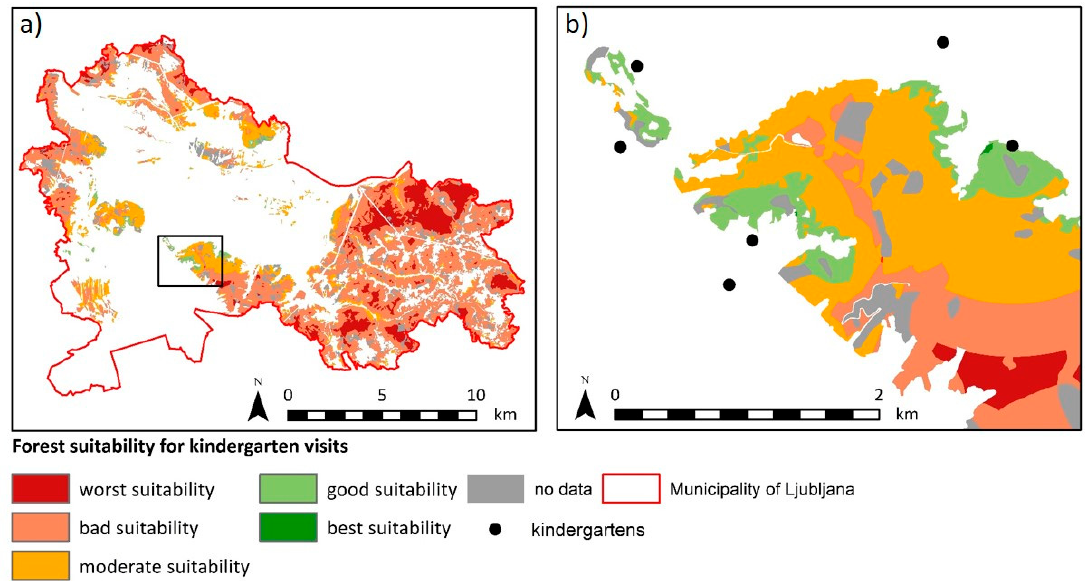
Figure 5. Forest suitability model for a visit with kindergarten groups of children ( a ) and enlarged city centre area ( b ).